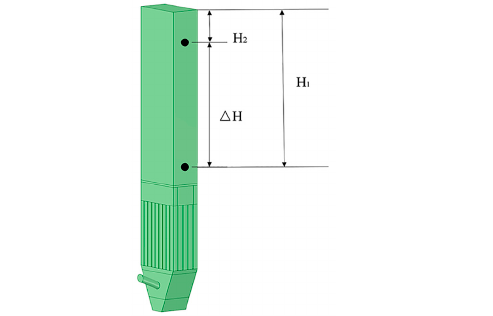
Figure 1. Differential pressure-based concentration detection device and system. ( a ) Differential pressure-based concentration detection device. ( b ) Differential pressure-based concentration detec- tion system.